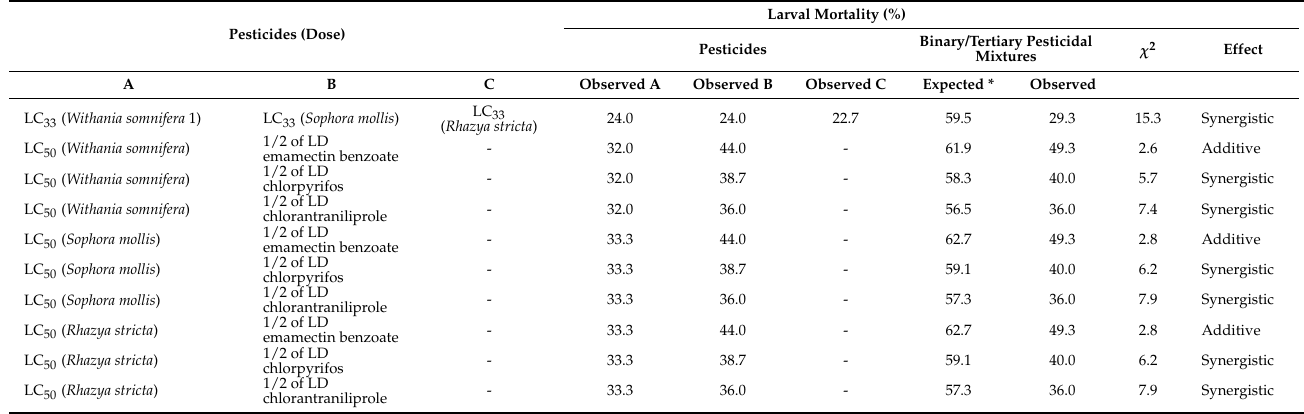
Table 5. Combined effect of binary/tertiary pesticidal mixtures against 3rd instar larvae of the fall armyworm Spodoptera frugiperda .